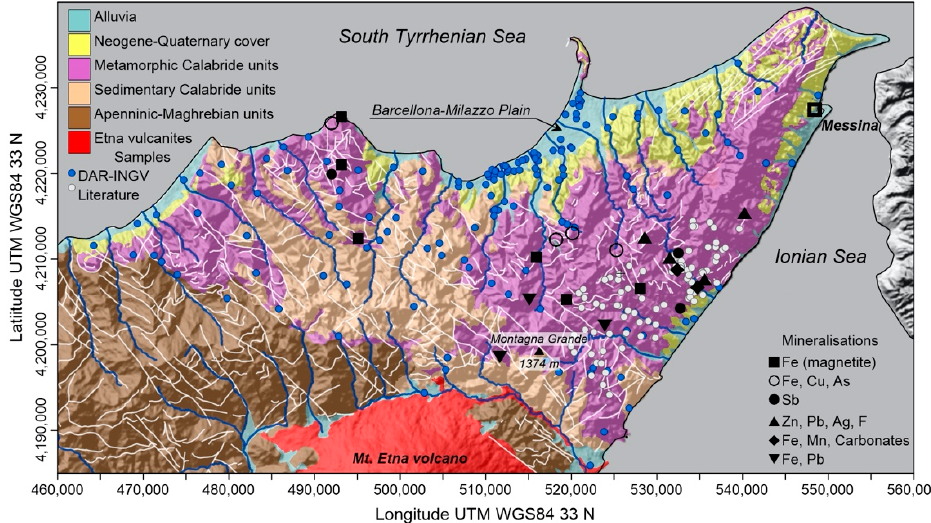
Figure 1. Shaded relief map of the Peloritani Mts area reporting locations of the sampling points, surface geology and fault network (modified from [12]).